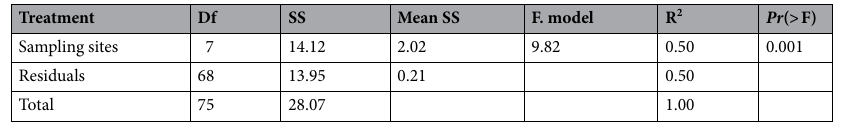
Table 3. PERMANOVA results based on Bray–Curtis dissimilarities evaluating differences in the bacterial community composition between Aedes japonicus , Aedes triseriatus , water samples at each individual sampling site at South Farms study location. P-values are based on 999 permutations.